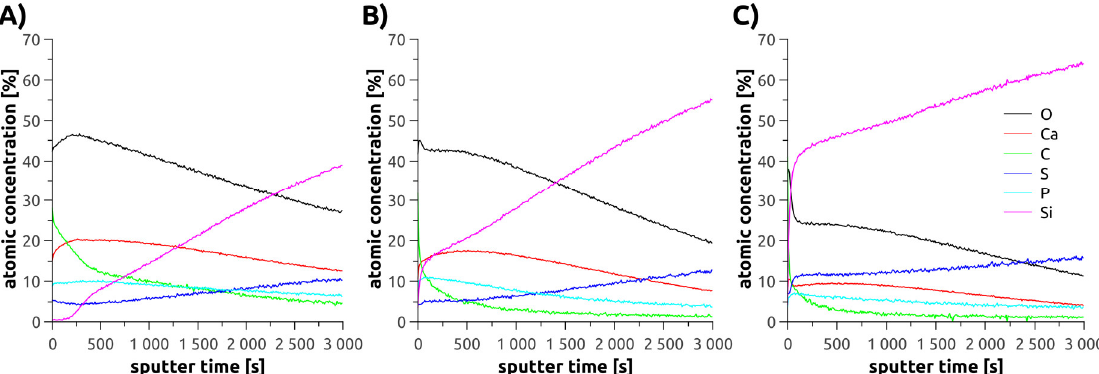
Figure 4. X-ray photoelectron spectroscopy (XPS) sputter depth profiles of the mineralized polymer brushes ( A ) Min1, ( B ) Min2, and ( C ) Min3. XPS raw data are summarized in the supporting information (Table S2).